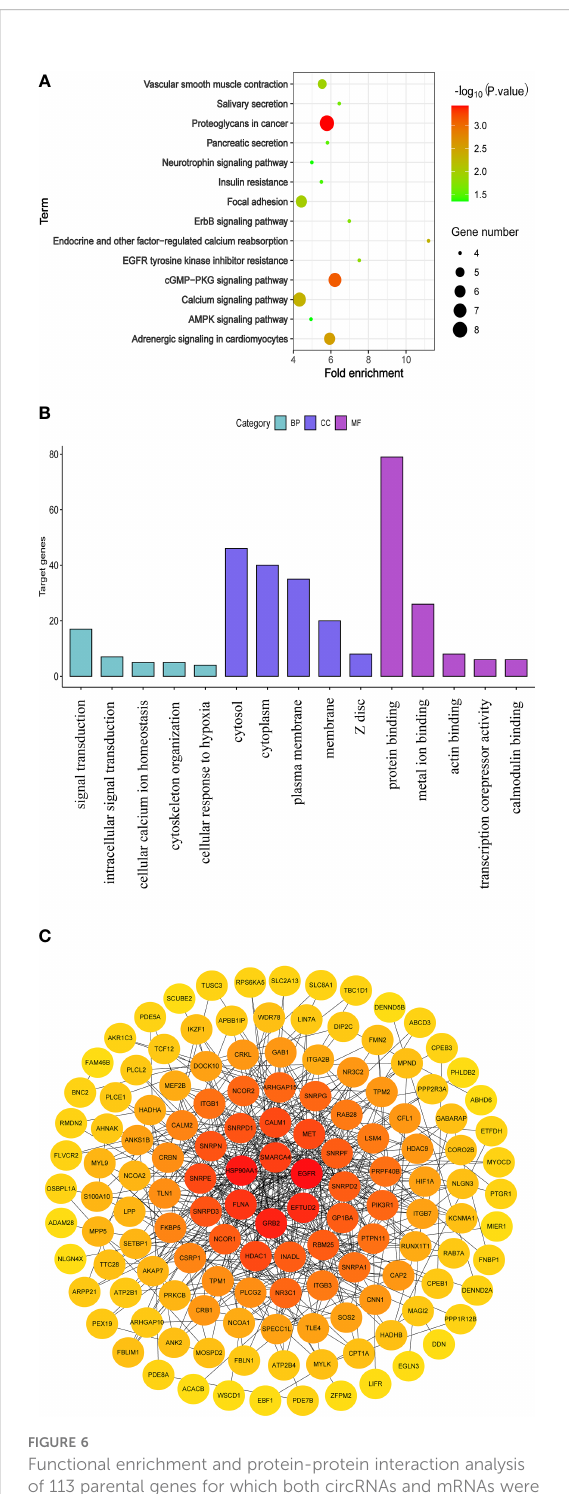
FIGURE 6 Functional enrichment and protein-protein interaction analysis of 113 parental genes for which both circRNAs and mRNAs were down-regulated. (A) KEGG pathway analysis. (B) GO analysis (C) The network of